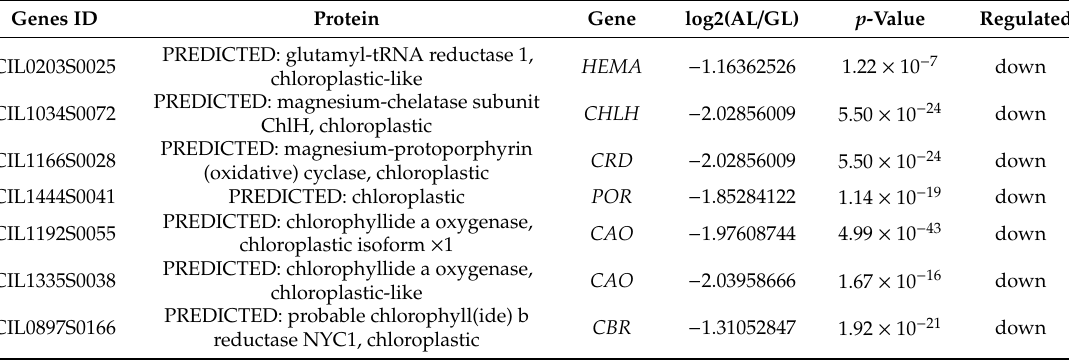
Table 4. Identified di ff erentially expressed proteins involved in chlorophyll